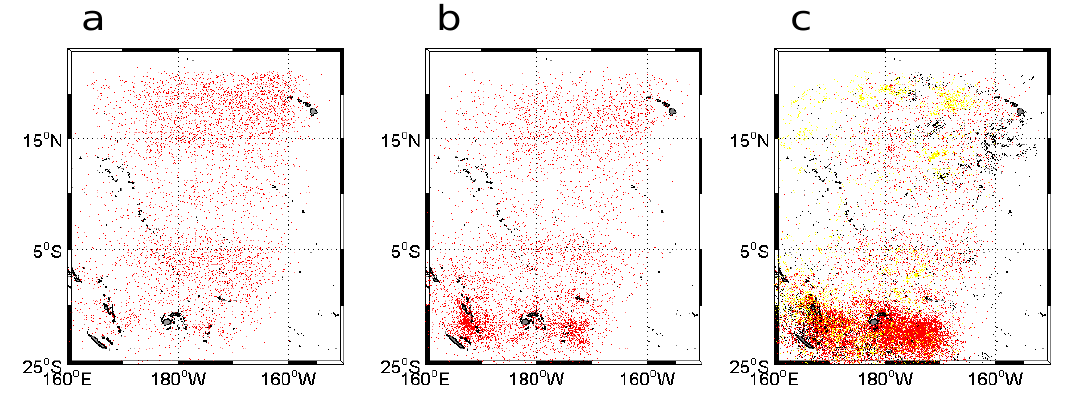
Fig. 6. Application of the TRICHOSAT algorithm to satellite data (1997 to 2010) over the large box corresponding to the Western Pacific Ocean (WP: 25 ◦ N–25 ◦ S/160 ◦ E–160 ◦ W); (a) austral winter (June to September); (b) interseason (April–May and October); (c) austral summer (November to March). The main islands of New Caledonia at 20 ◦ S, Vanuatu at 15 ◦ S, Fiji Islands at 17 ◦ S, Hawaii Islands at 20 ◦ N are indicated in grey.